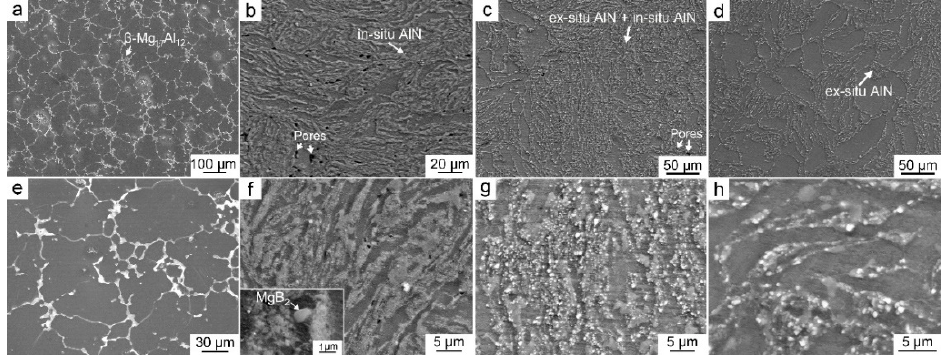
Figure 1. Microstructures of the Mg–8Al matrix alloy ( a , e ); 8.2AlN in /Mg–8Al ( b , f ); 8.2AlN (in+ex) /Mg– 8Al ( c , g ) and 8.2AlN ex /Mg–8Al ( d , h ) composites.